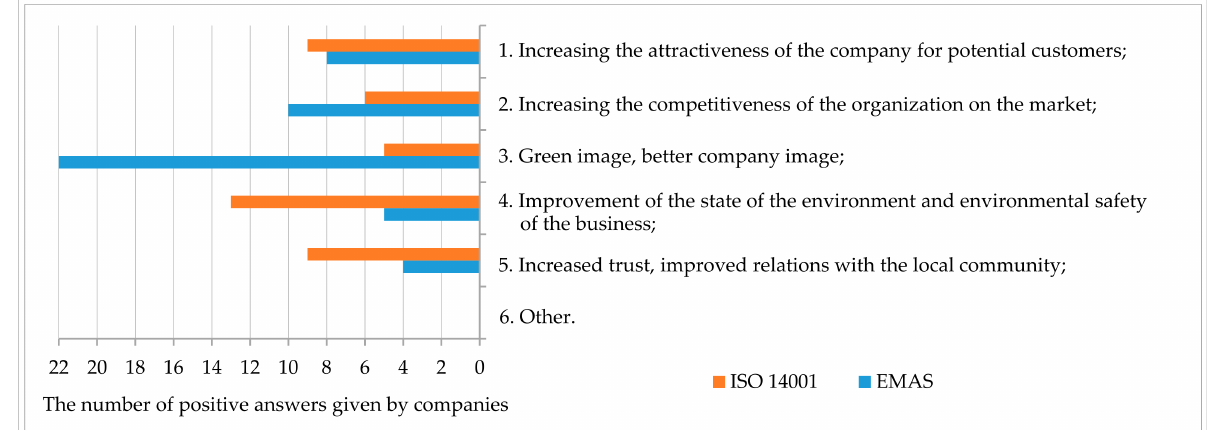
Figure 4. Answers to the fourth question of the survey: External benefits stemming from EMAS/ISO14001